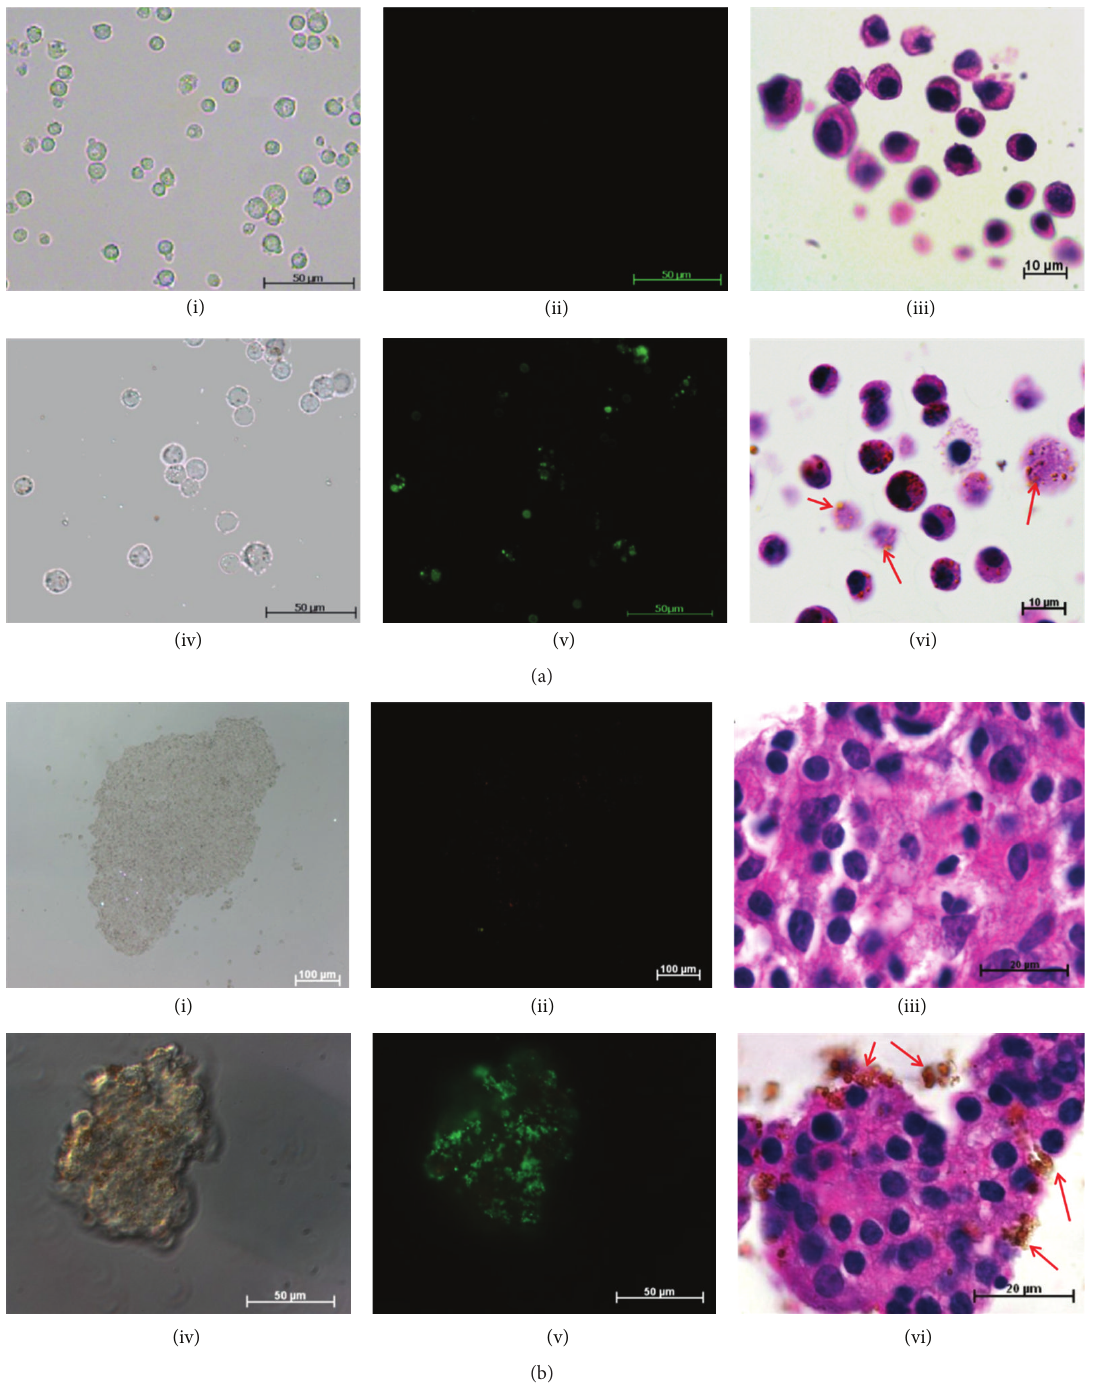
Figure 1: MM labelling. MM are readily taken up by both MIN6 (a) and human islets (b) by simple incubation for 24 hr in culture as evident from the phase contrast (a and b; iv), fluorescent (a and b; v), and histology (a and b; vi) images compared to unlabelled cells (a and b; i, ii, and iii). MM are seen as brown spots (arrows) and are scattered throughout the cytoplasm of both MIN6 (a; vi) and human islets (b; vi). Bar is 50 𝜇 m for (a) (i, ii, iv, and v) and (b) (iv and v), 100 𝜇 m for (b) (i and ii), 10 𝜇 m for (a) (iii and vi), and 20 𝜇 m for (b) (iii and